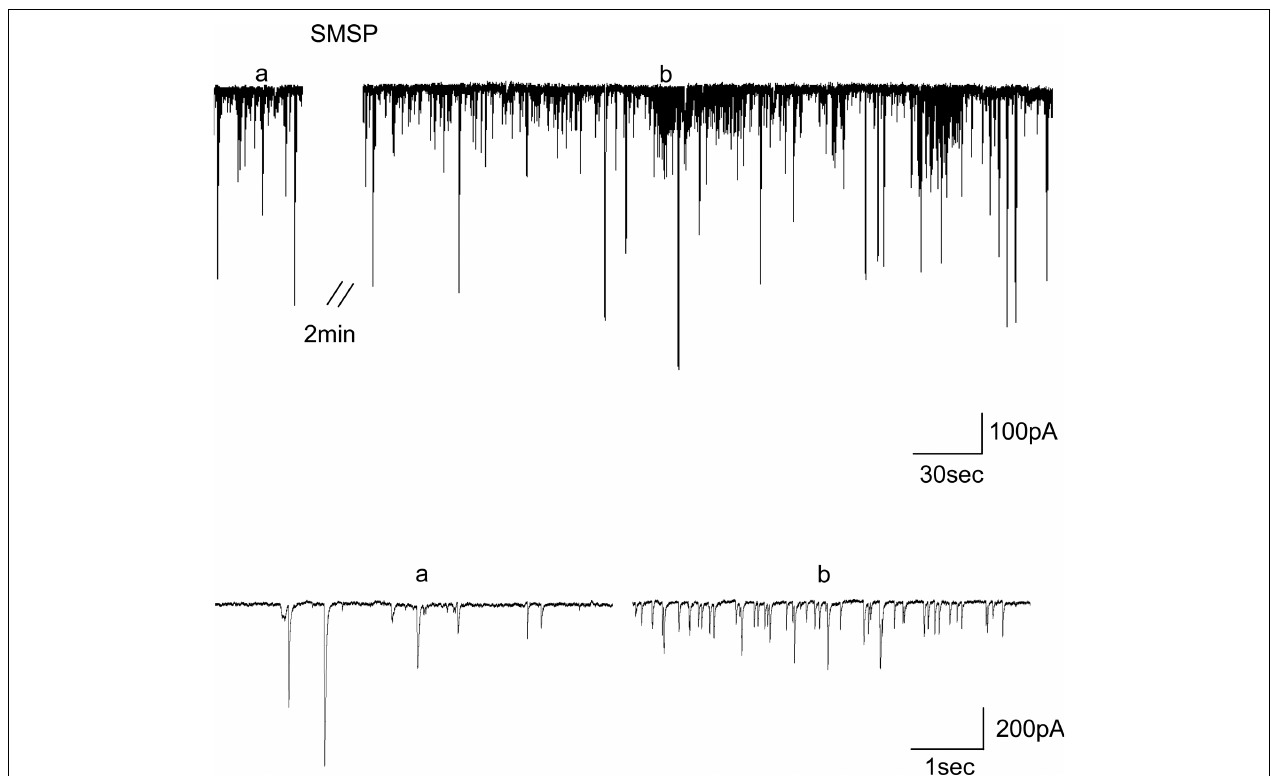
FIGURE 5 | Transient presynaptic facilitation of GABA release by 1 µM SM-SP. Typical traces showing that 1 µM SM-SP induced a transient increase in the frequency of mIPSCs. a and b indicated the time from which the traces plotted on a fast time-base were taken.